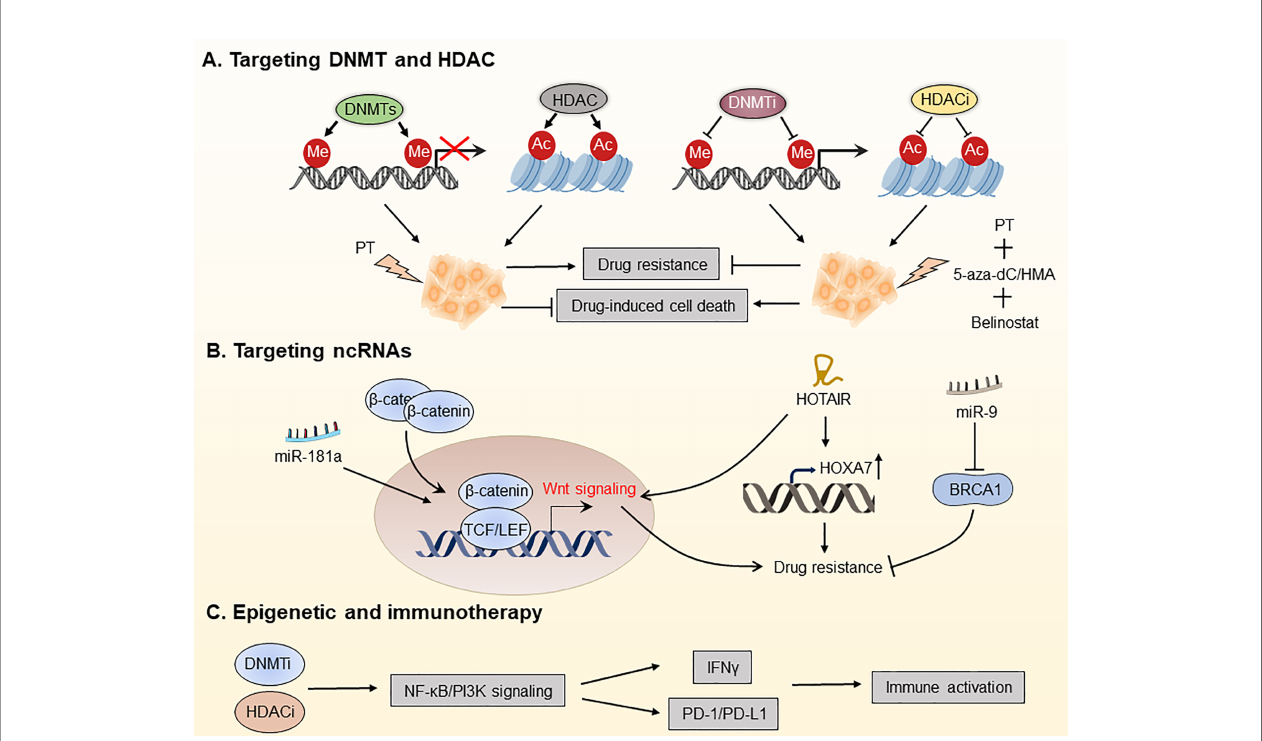
FIGURE 5 | Targeting the OC epigenome and overcoming drug resistance in OC. (A) Platinum therapy combined with DNA methyltransferase inhibitors (DNMTis) and histone deacetylation inhibitors (HDACis) has been used for chemotherapeutic sensitization. (B) Overcoming OC drug resistance by targeting certain ncRNAs. (C) DNMTi and HDACi increased the responsiveness of OC to immune checkpoint therapy by reducing the immunosuppressive milieu via the type I IFN signaling pathway. PT, platinum; 5-aza-dC, 5-aza-2-deoxy-cytidine; HMA, hypomethylating agent; PD-1, programmed death protein 1; PD-L1, programmed death ligand